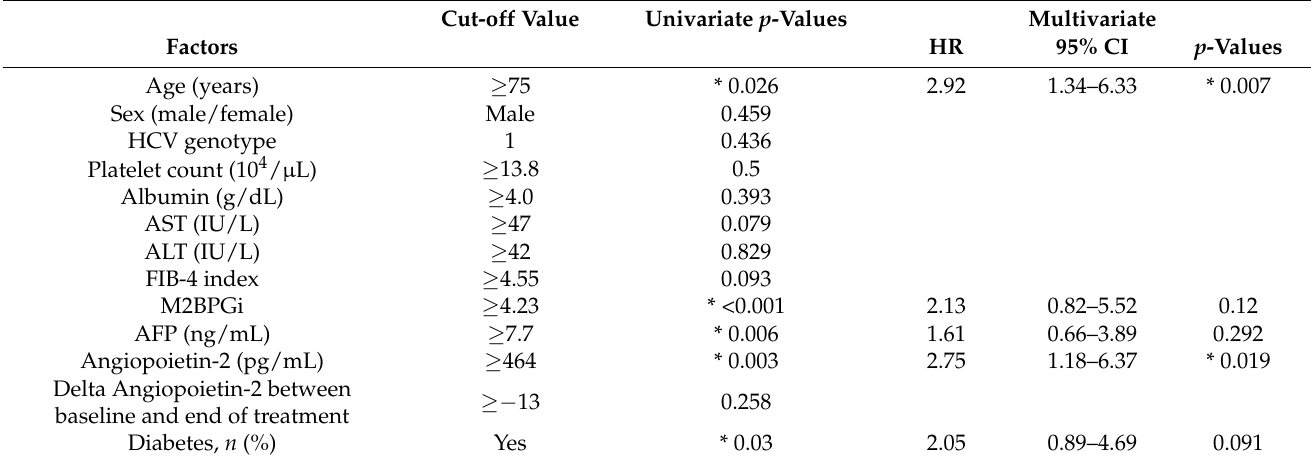
Figure 1. Cumulative incidences of HCC occurrence and recurrence following the initiation of DAA therapy. HCC, hepatocellular carcinoma; DAAs, direct-acting antivirals. Table 2. Baseline factors associated with HCC occurrence after DAA